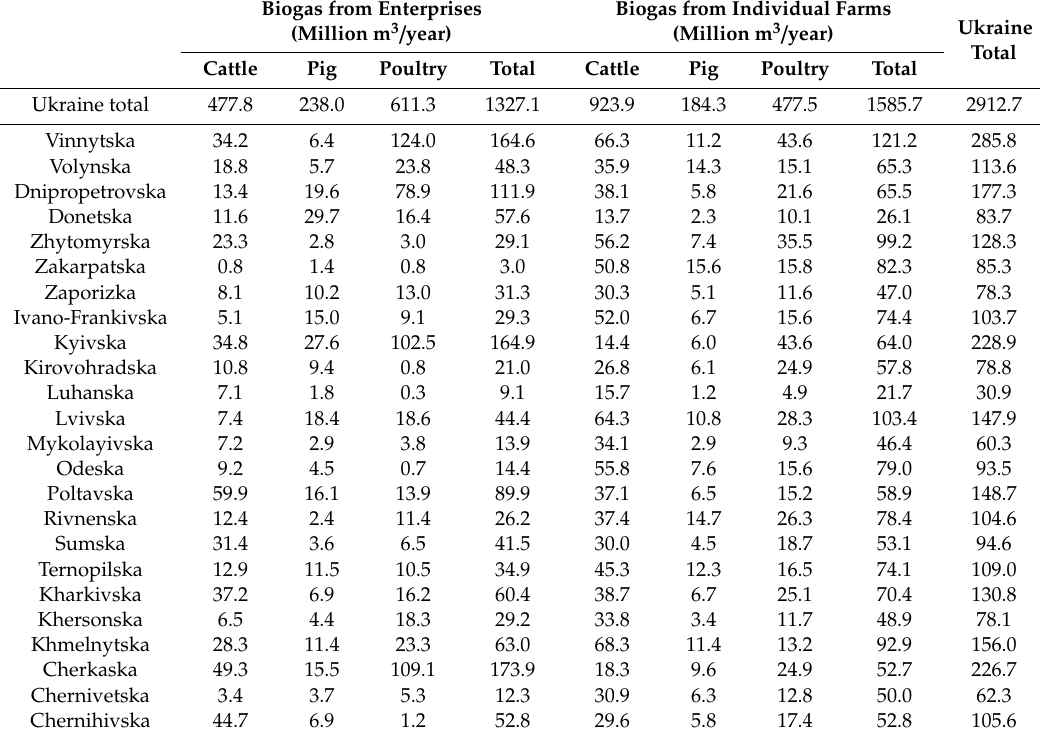
Table 4. Theoretical biogas yield in manure-based biogas plant in